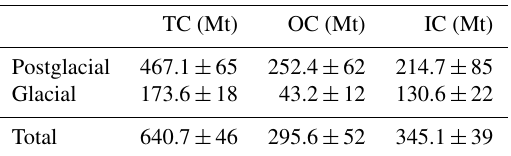
Table 3. Total C stored in the sediment of Scotland’s 111 fjords further broken down into the quantities of OC and IC stored in the postglacial and glacial sediments.